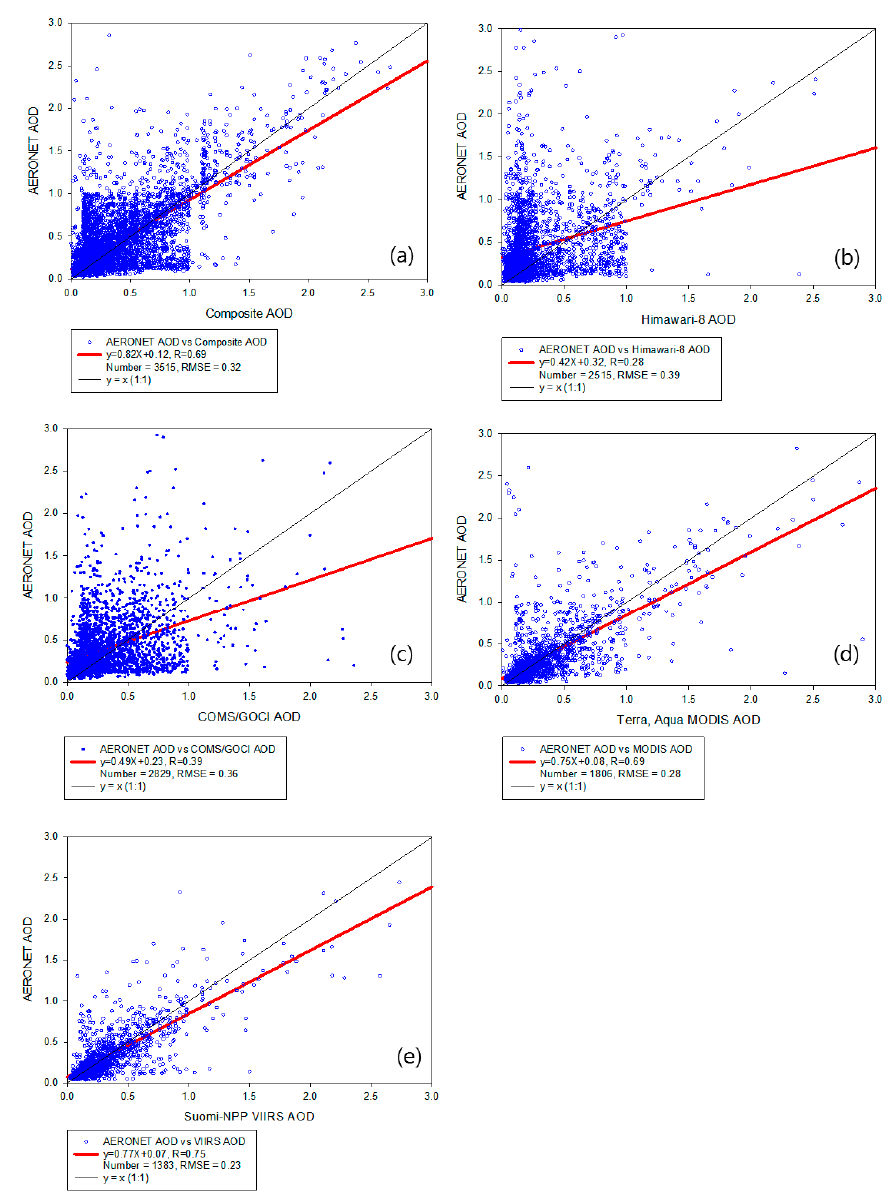
Figure 8. AOD scatterplots from ( a ) Composite, ( b ) Himawari-8/AHI, ( c ) COMS/GOCI, ( d ) Aqua Terra/MODIS, and ( e ) Suomi-NPP/VIIRS against ground-based reference AERONET data for 15 sites from January to December 2017. Solid red line is the linear regression, and the black line is 1:1. Table 4. Summary statistics for composite, satellites, and AERONET AOD products during 2017.